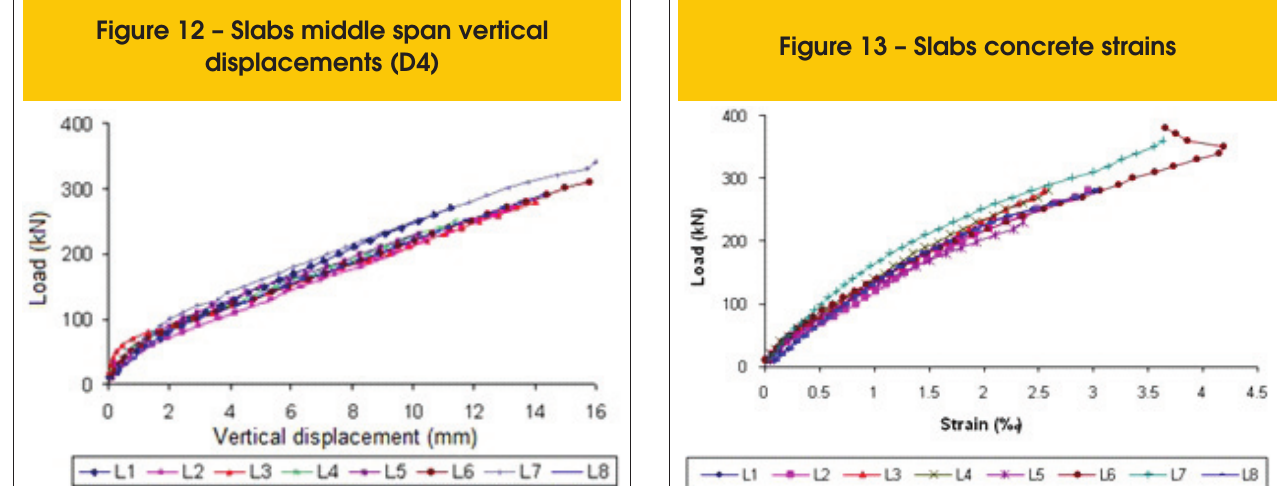
Figure 13 – Slabs concrete strains